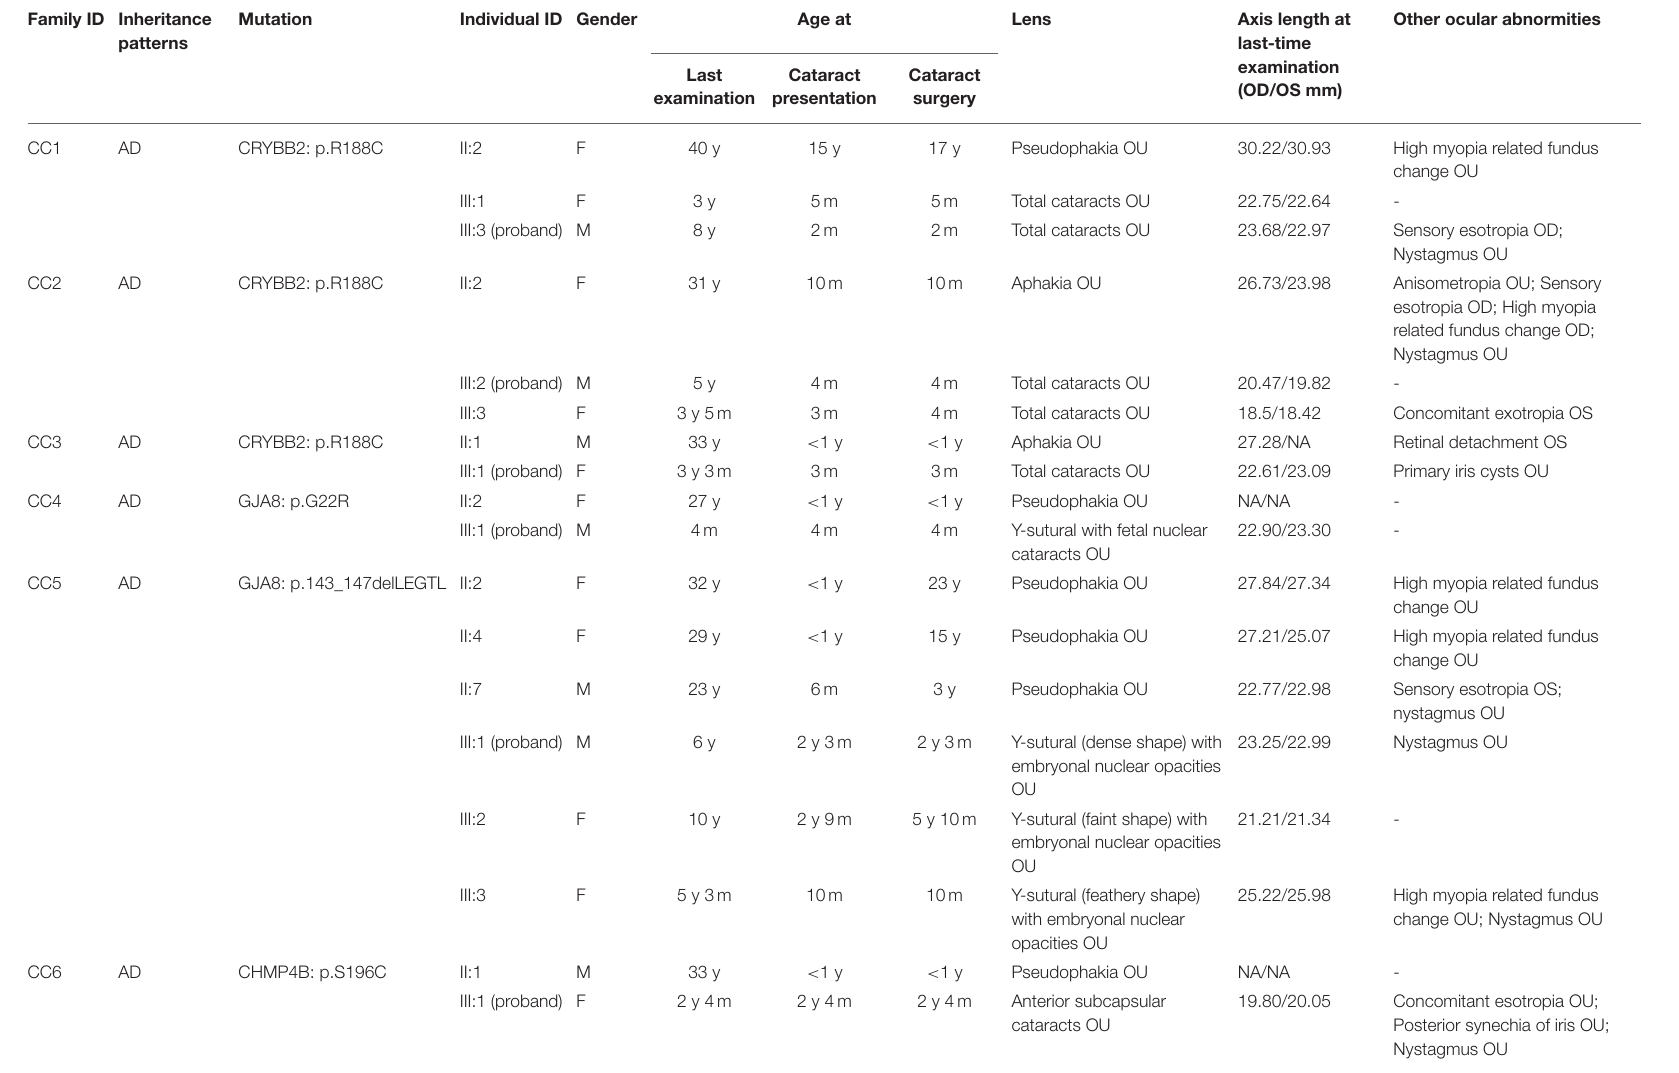
TABLE 2 | Clinical characteristics of affected members in the six Chinese Han